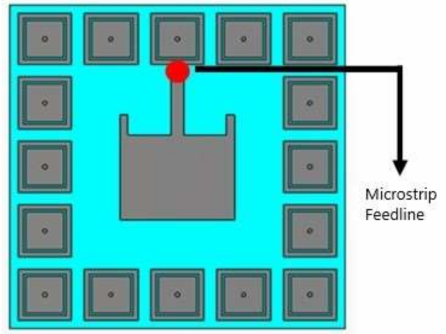
Figure 8. Geometric model of the dual-band EBG-based